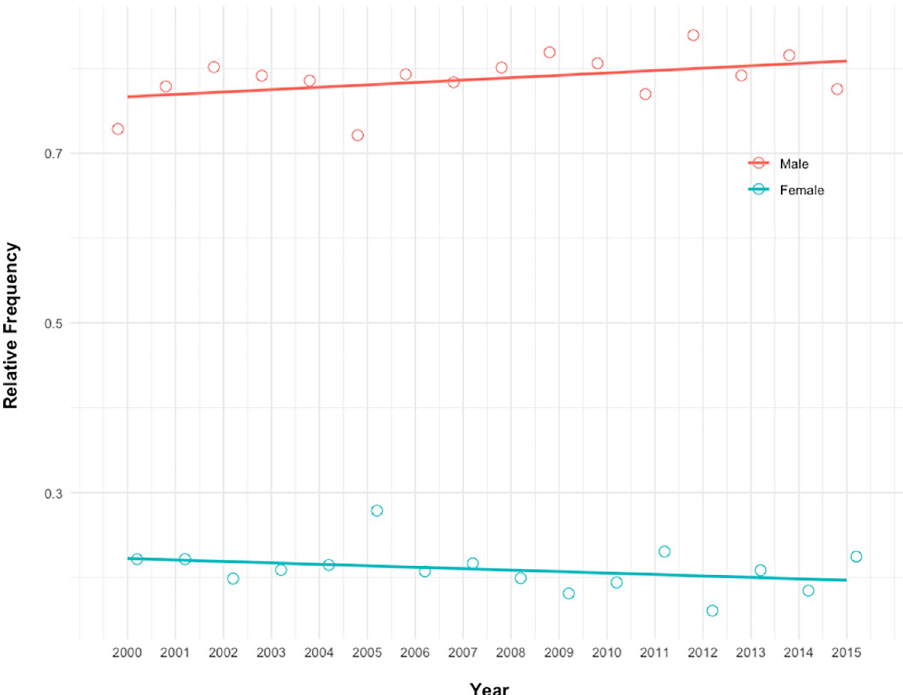
Fig 2. Temporal trends. Temporal trends in the relative frequency of isolated coronary artery grafting (CABG) by sex. https://doi.org/10.1371/journal.pone.0275035.g002 Table 1. Baseline characteristics.